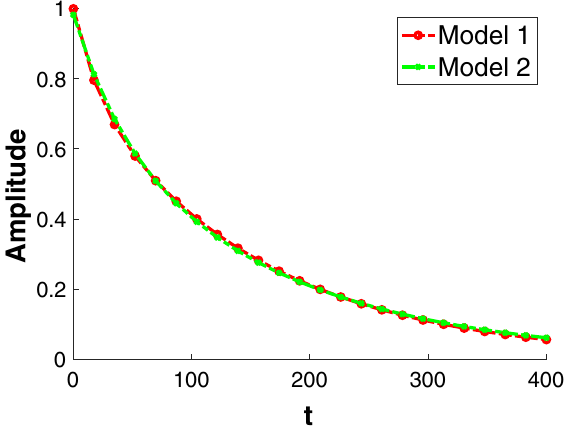
Figure 1. Plot of biexponential decaying signals generated by two different models. The governing equations for the models are S 1 ( t